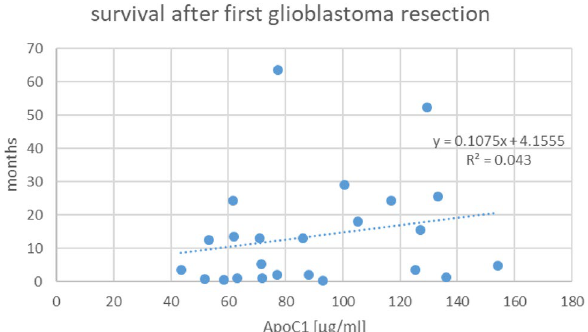
Figure 1. Survival time of 24 patients in function of their averaged ApoC1 serum levels (mean value from all samples taken in an individual patient during the study period). The deviation of the regression line from horizontal is not